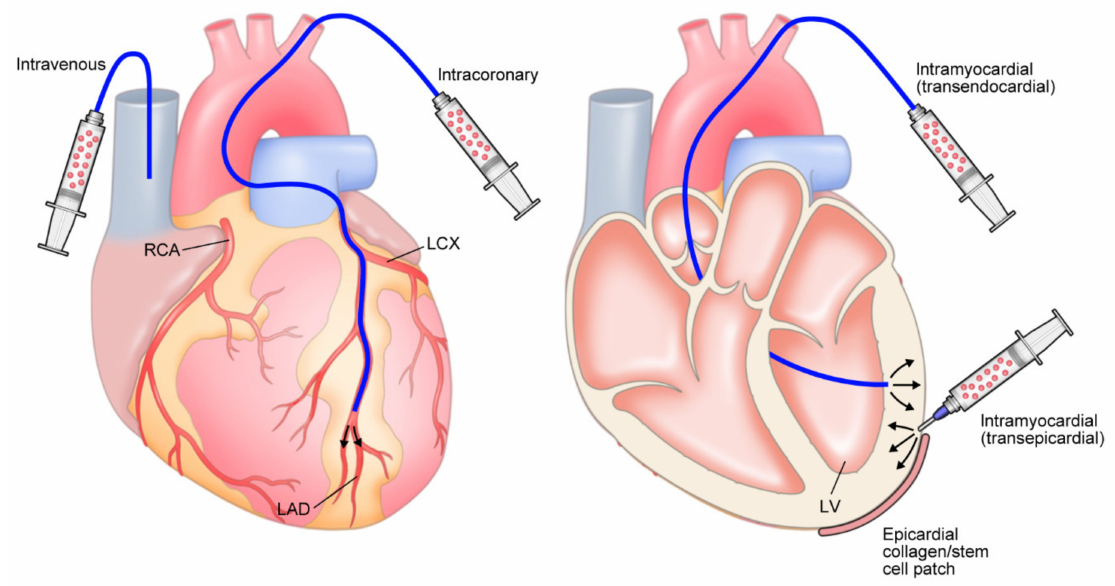
Figure 2. Overview of implantation methods and devices for engrafting hiPSC-CMs. hiPSC, human- induced pluripotent stem cell-derived cardiomyocyte; LAD, left anterior descending; LCX, left circumflex coronary artery; LV, left ventricle; RCA, right coronary